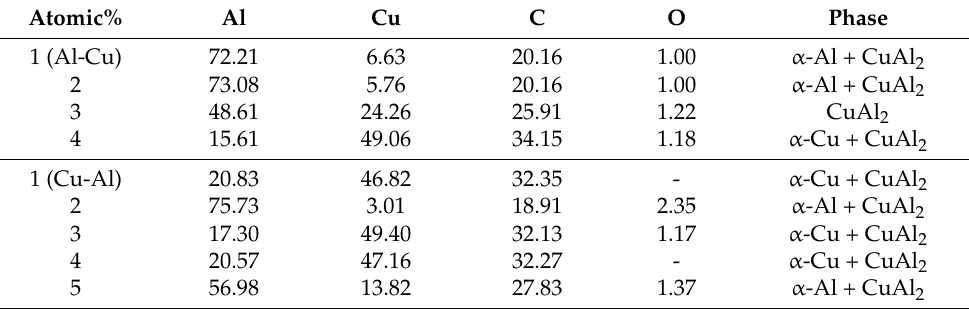
Table 4. EDS point analysis and phase